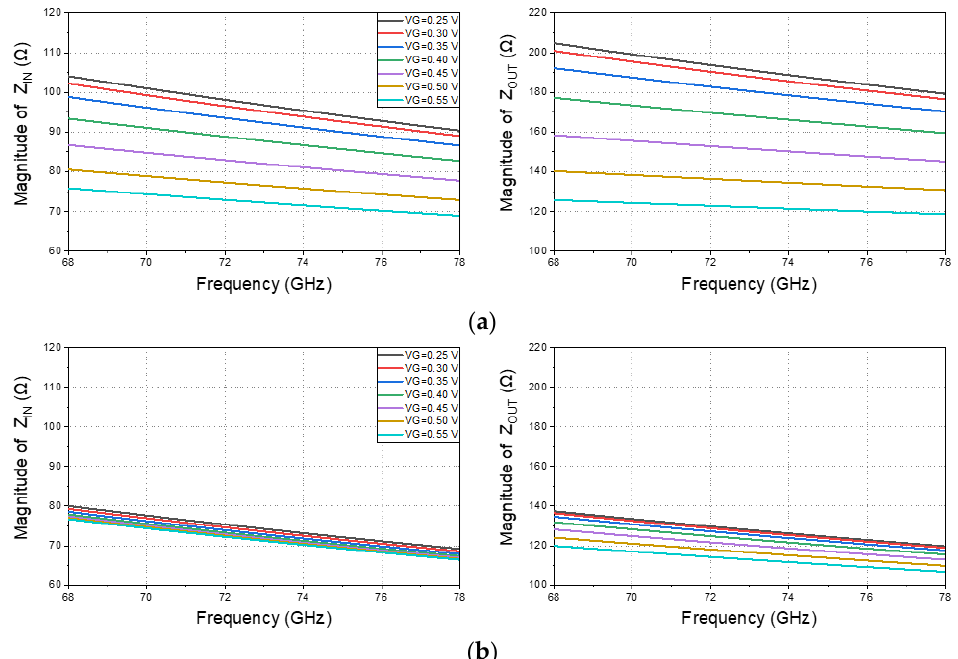
Figure 6. ( a ) Magnitude of input and output impedances ( Z in and Z out ) of a single-stage differential amplifier core without neutralization and ( b ) with neutralization.